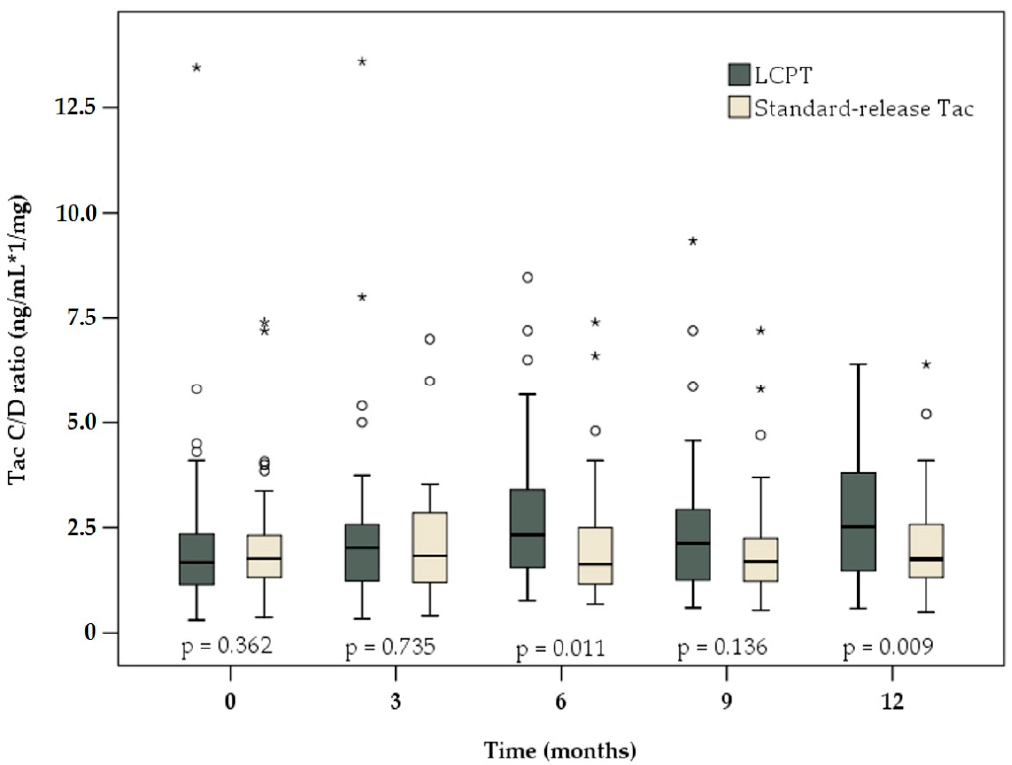
Figure 2. Boxplots of C / D ratio among patients receiving LCPT (dark grey) or standard-release Tac (light brown) at baseline and 3, 6, 9 and 12 months later. There were significant di ff erences between the two study groups at 6 and 12 months after conversion. p -values reflect di ff erences between the groups at each time point.